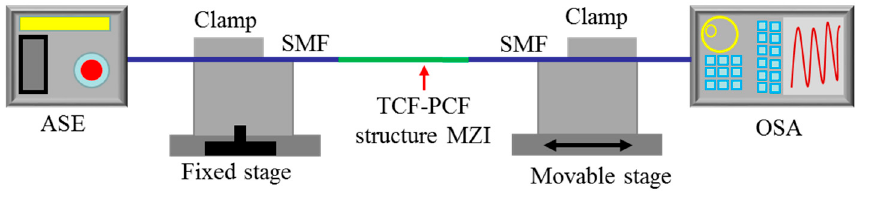
Figure 4. Experimental step for strain measurement.